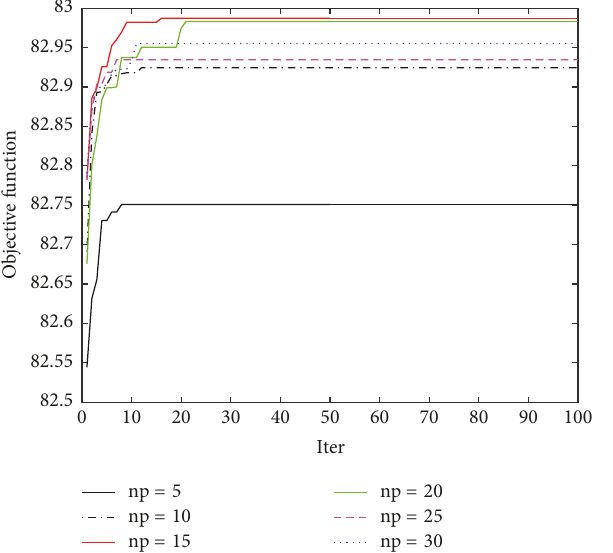
Figure 3: Convergence curve of ICSC algorithm on number 1 subnetwork of DIP dataset.